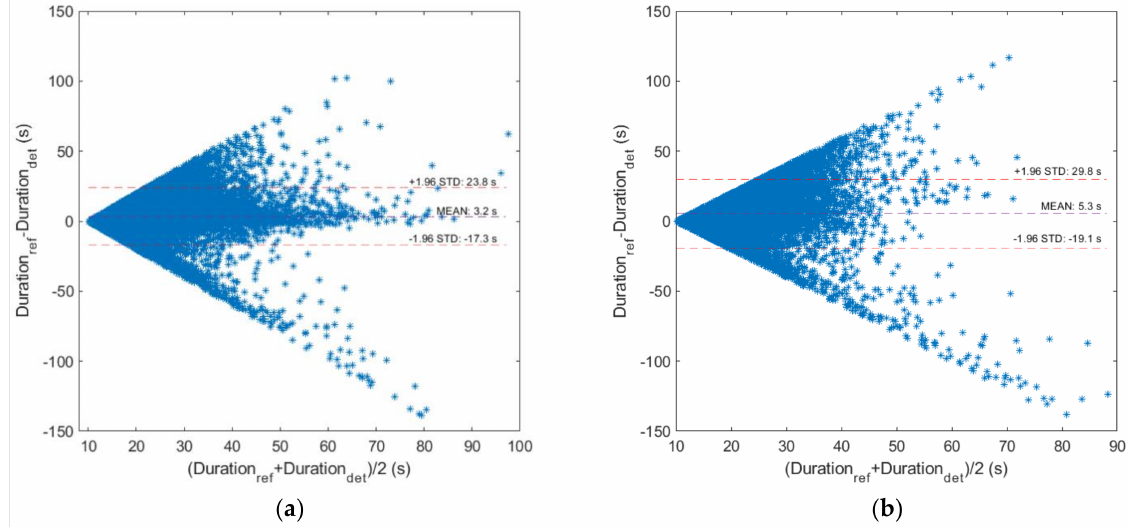
Figure 5. Bland-Altman diagrams for the reference and detected duration of all true positive apnea/hypopnea events: ( a ) for the case of tracheal sound recordings; ( b ) for the case of ambient sound